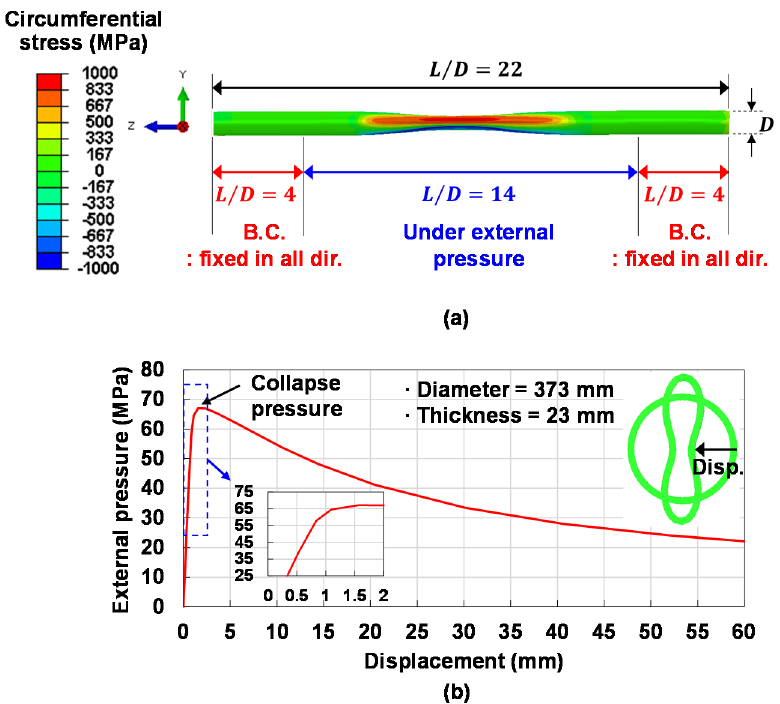
Figure9. Collapse analysis: ( a ) boundaryand loadconditions; ( b ) displacementunder Figure 9. Collapse analysis: ( a ) boundary and load conditions; ( b ) displacement under external pressure.